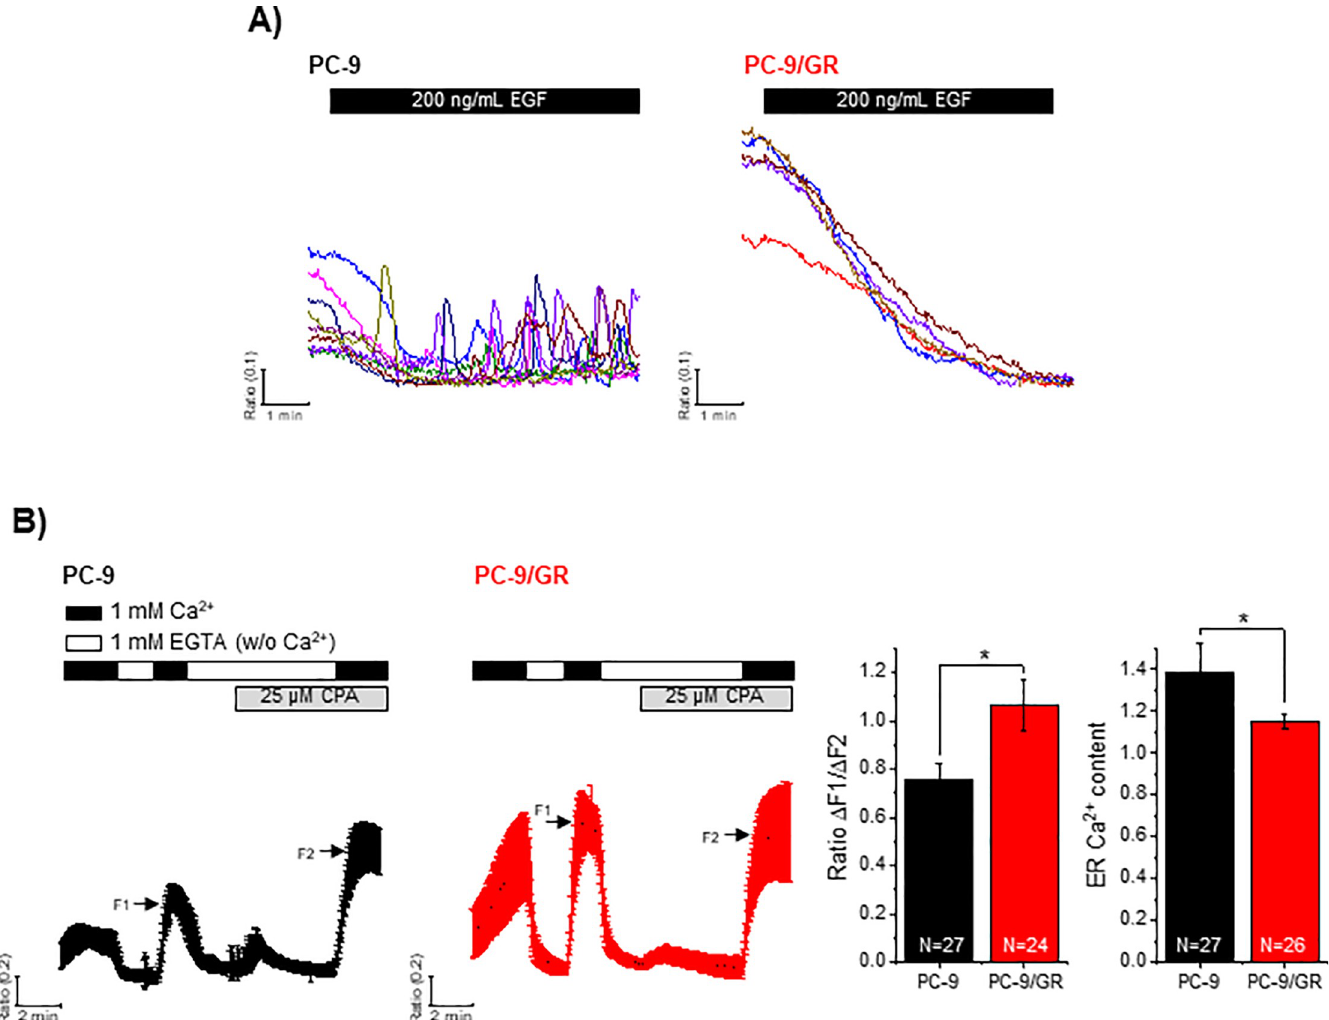
Fig 1. Differential [Ca 2+ ]i responses between PC-9 and PC-9/GR cells. Intracellular free Ca 2+ in live single cell was determined using Fura-2/AM fluorescent dye. (A) EGF-mediated [Ca 2+ ]i responses were measured in PC-9 and PC-9/GR cells. Each trace represents [Ca 2+ ]i mobilization in a single cell. (B) ER Ca 2+ content, spontaneous [Ca 2+ ]e influx ( Δ F1), and [Ca 2+ ]i entry via SOCC ( Δ F2) were determined is response to CPA (indicated as F1) and rescue of [Ca 2+ ]e (indicated as F2) in PC-9 and PC-9/GR cells. The columns show the mean ± S.D. � P < 0.05.